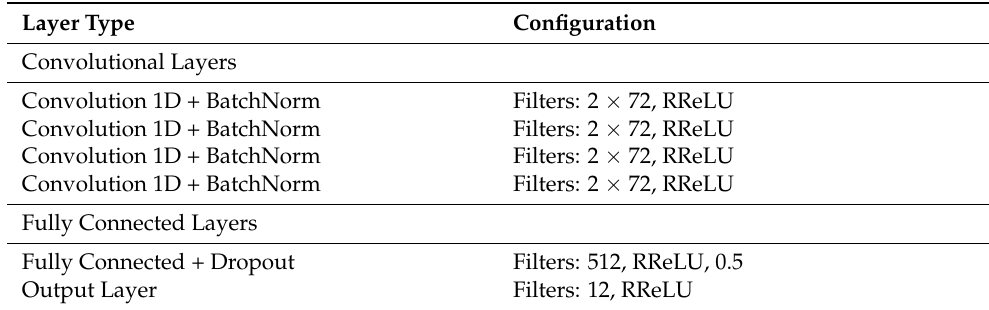
Table 3. The architecture of CNNs.